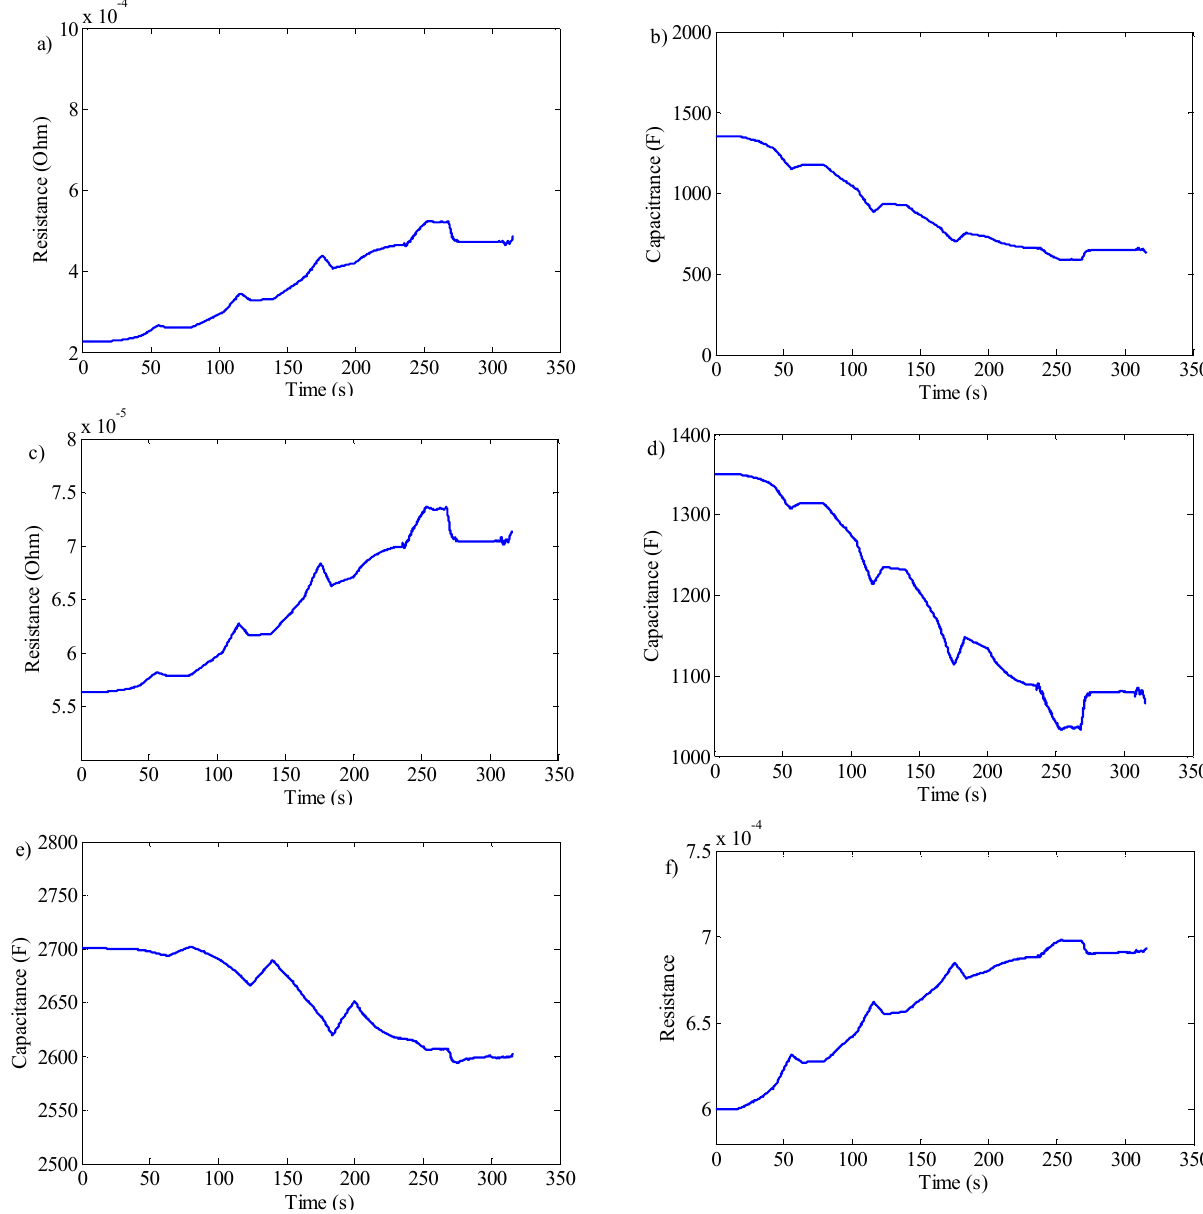
Figure 5. The evolution of the estimated model parameters in the DST test: (a